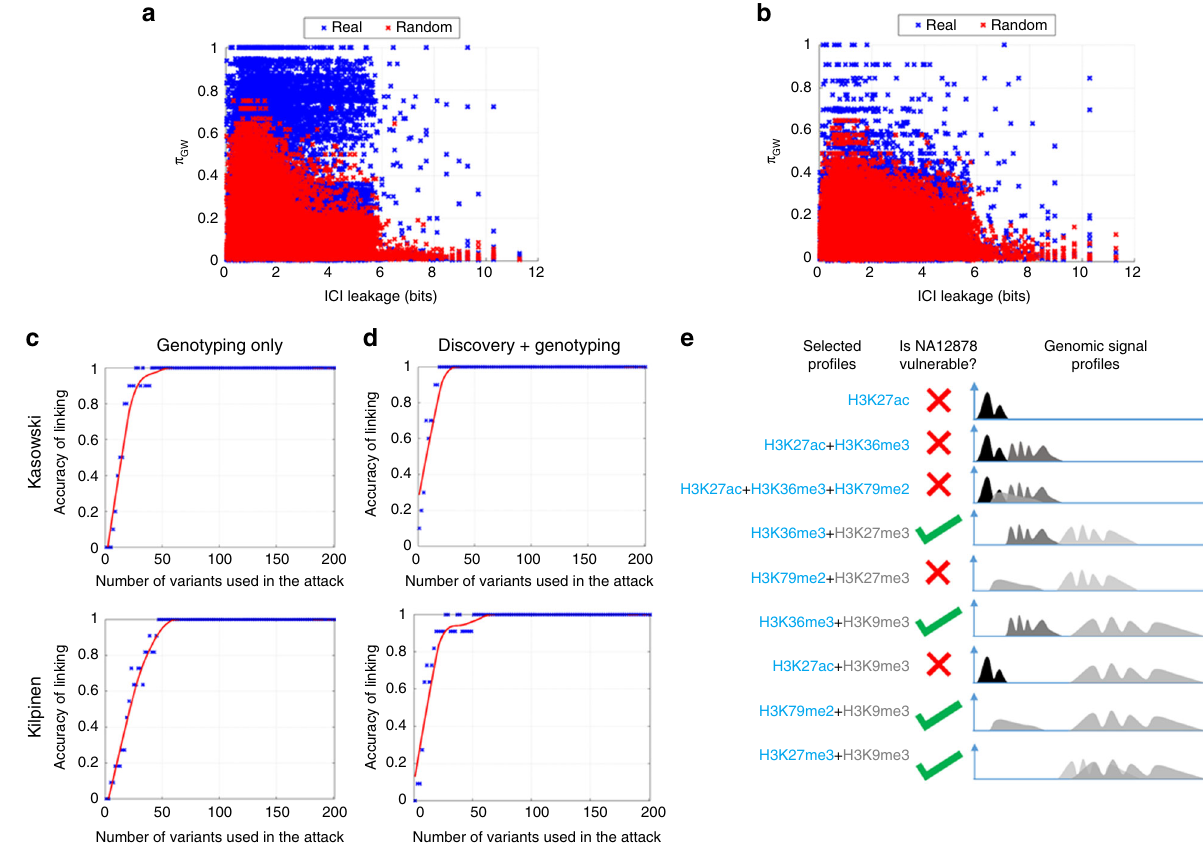
Fig. 4 Leakage from ChIP-Seq signal pro fi les through small deletions. a , b Scatter plots show ICI leakage vs. predictability for Kasowski ( a ) and Kilpinen ( b ) datasets. c The accuracy of linking attack on the two datasets for a genotyping only scenario. The x -axis shows the changing number of variants used in the attack and the y -axis shows the linking accuracy. d The accuracy of linking on the two datasets when the adversary performs the attack by joint discovery and genotyping of deletions. e The accuracy of linking of NA12878 when adversary utilizes different combinations of histone modi fi cations. The fi rst column shows different combinations. The middle column indicates whether NA12878 is identi fi able among 1000 Genomes samples, represented by green check for yes and red cross for no. The third column is a schematic representation of signal pro fi les for each